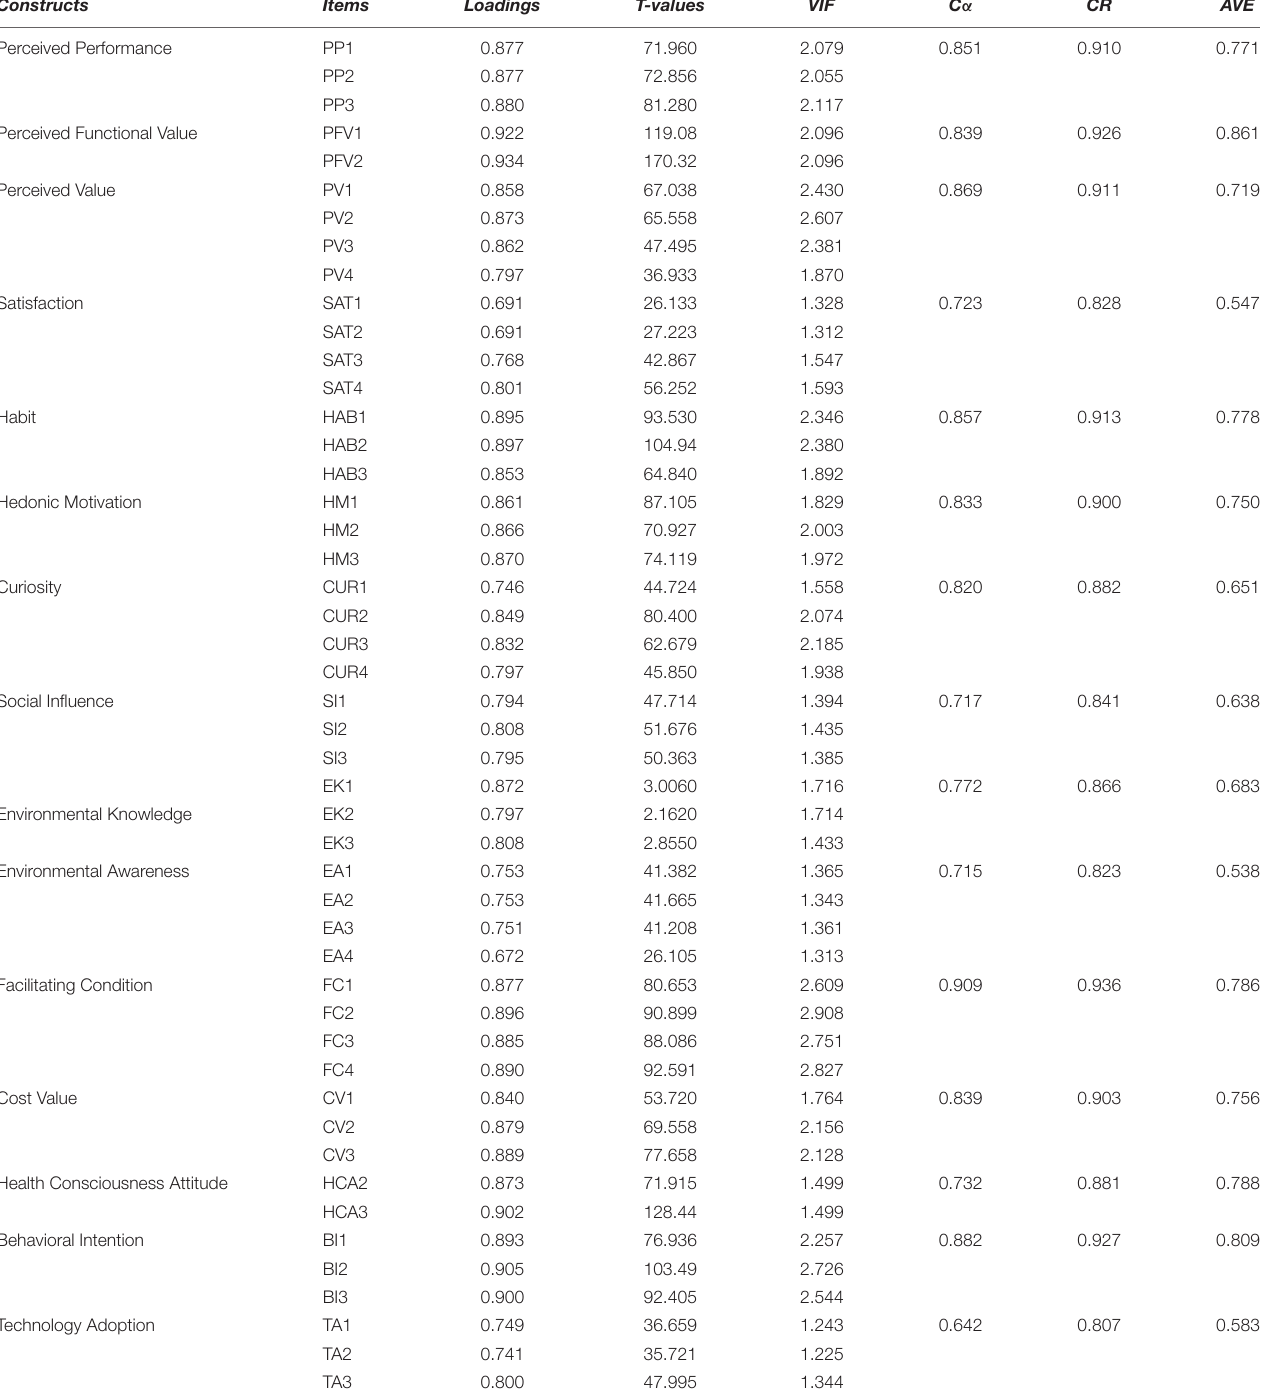
TABLE 2 | Reliability and validity